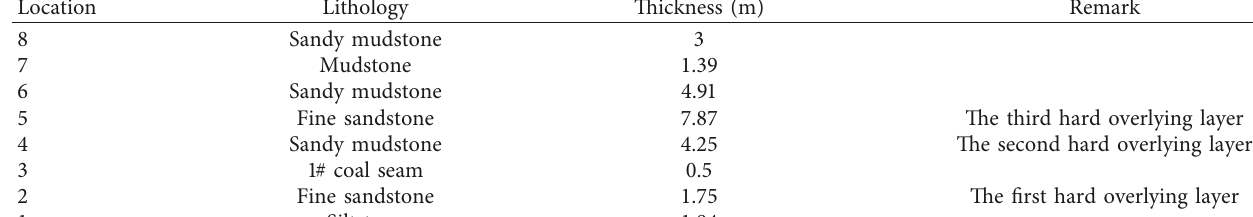
Table 3: Overlying layers of #2 coal seam.